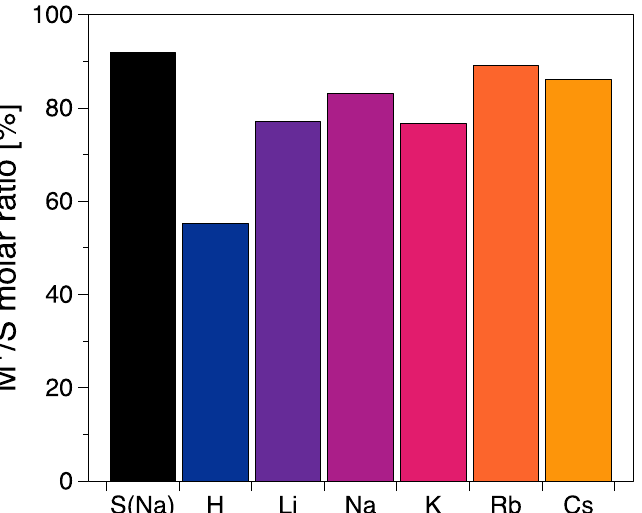
Figure 2. Molar ratio between the corresponding metal cation (M + /S) and sulfur introduced on the CNCs. The atomic composition, determined using XPS (Supporting Information Table S1), confirmed the elemental composition by the ICP-OES (Table S1), and additionally indi- cated that chlorides were not present in the modified CNCs. However, the low amounts of the cations and the sulfur (<0.4 at.%), and the differentiating susceptibility of the ele- ments, impede a thorough quantitative analysis of the spectra (hence, Li-CNC is not pre- sented). For instance, the concentration of residual sodium in the exchanged suspensions cannot be determined due to its low concentration. However, XPS enables to assess the chemical environment of the surface species. As XPS is sensitive in chemical bonding, the metal ions experience a similar coordination environment in the metal ion modified CNCs (M-CNCs) as in the pure sulfates. The binding energies of the metal peaks in the XPS spectra of the corresponding metal sulfates and the ion-exchanged sulfated CNCs are in a good agreement (Table S2) [22]. The appearance of the CNCs did not change by the cation exchange, as evidenced by AFM imaging of the CNCs on a support (Figure 3). We also analyzed the hydrodynamic diameter in the 0.050 and 0.025 wt.% suspensions; however, no trend of occupied space taken by the CNCs could be detected (Supporting Information, Figure S1).